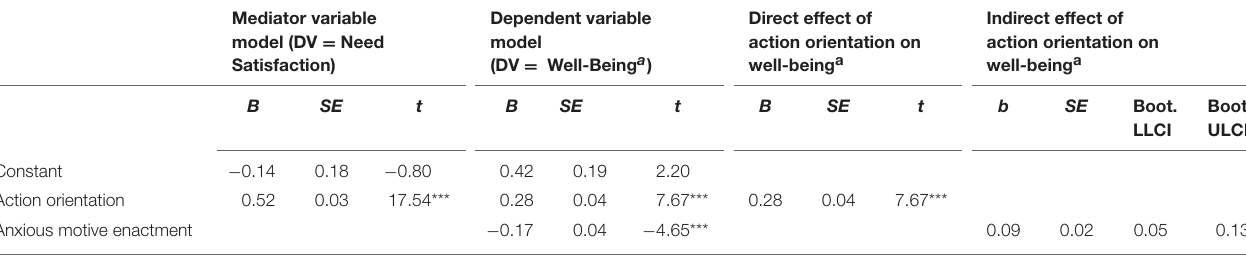
TABLE 4 | Summary of the Direct Effect of Action Orientation (Predictor) on Well-being (Outcome) and the Indirect Effect of Action Orientation through Anxious Motive Enactment (Mediator) on Well-being for the Whole Sample (Controlling for Gender and